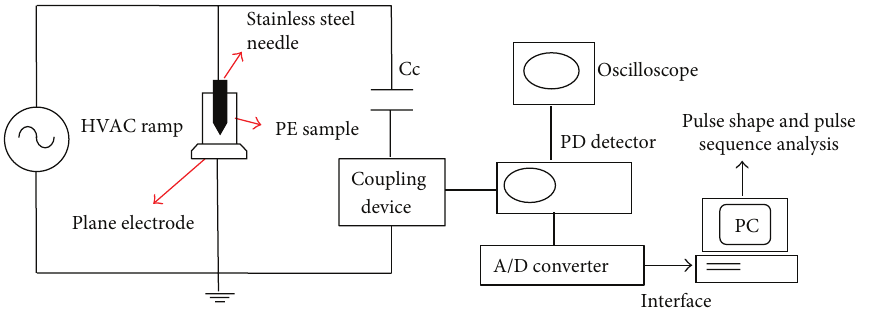
Figure 13: Simplified schematic diagram for PD measurement [30].